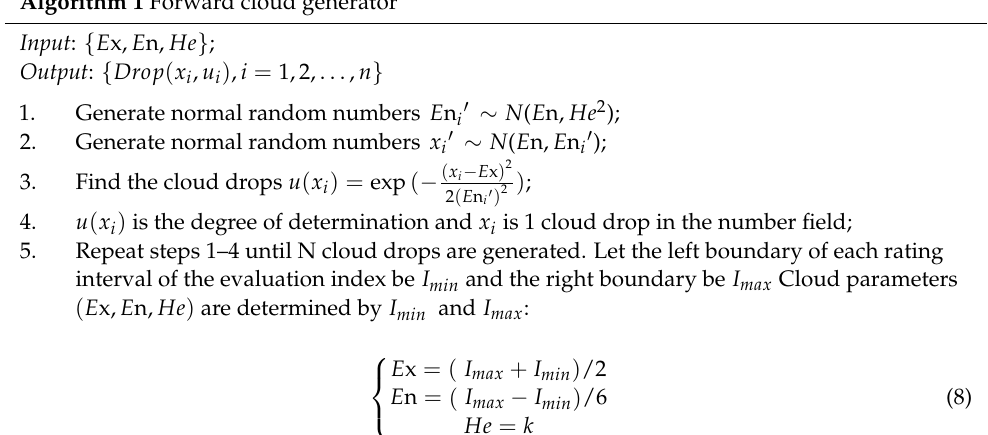
Algorithm 1 Forward cloud